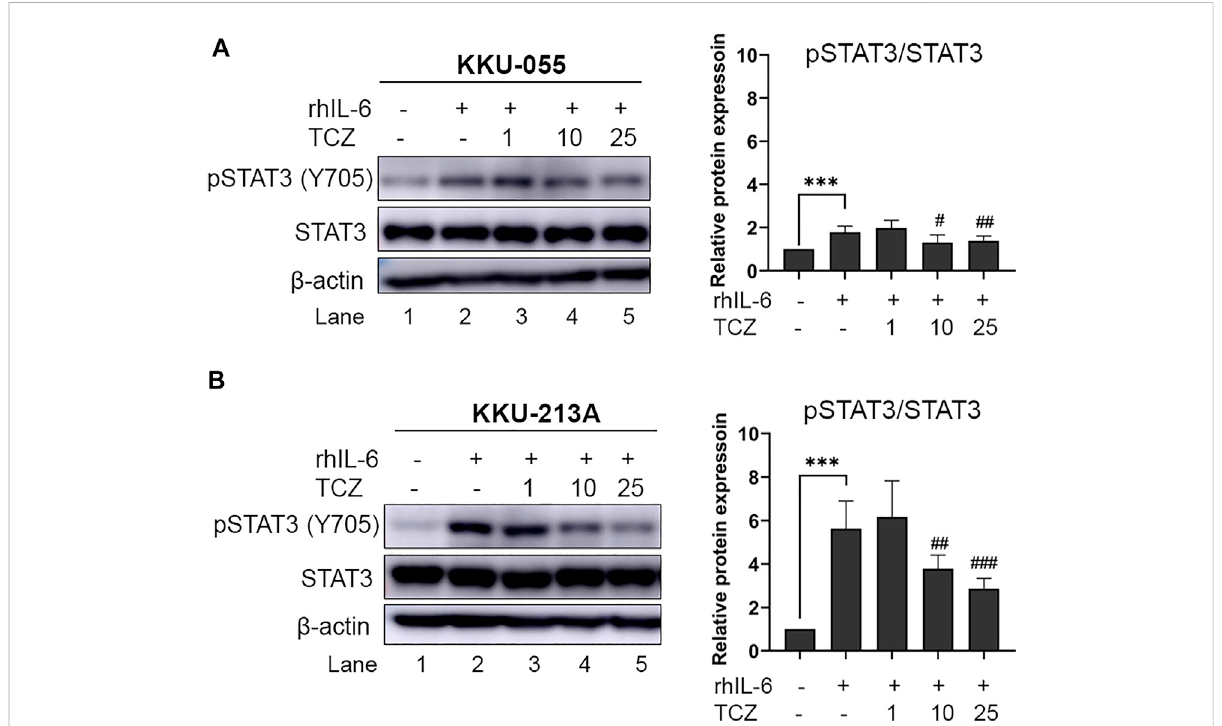
FIGURE 4 Theef fi cacyofIL-6Rinhibitor(Tocilizumab)onpSTAT3levelsofrhIL-6-treatedCCAcells.ThelevelofpSTAT3in (A) KKU-055and (B) KKU-213A after treatment with different concentrations of TCZ was assessed by western blot analysis. The graphical plots demonstrate relative protein expression of pSTAT3 and total STAT3. TCZ; tocilizumab. Error bars represent the standard deviation (SD) of triplicate experiments. A signi fi cant difference was determined using ANOVA and unpaired t-test (*** p < 0.001 compared to untreated groups, # p < 0.05, ## p < 0.01, ### p < 0.001 compared to rhIL-6 treated